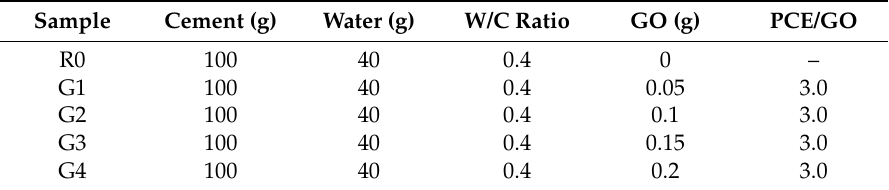
Table 4. Mix proportions of GO/cement